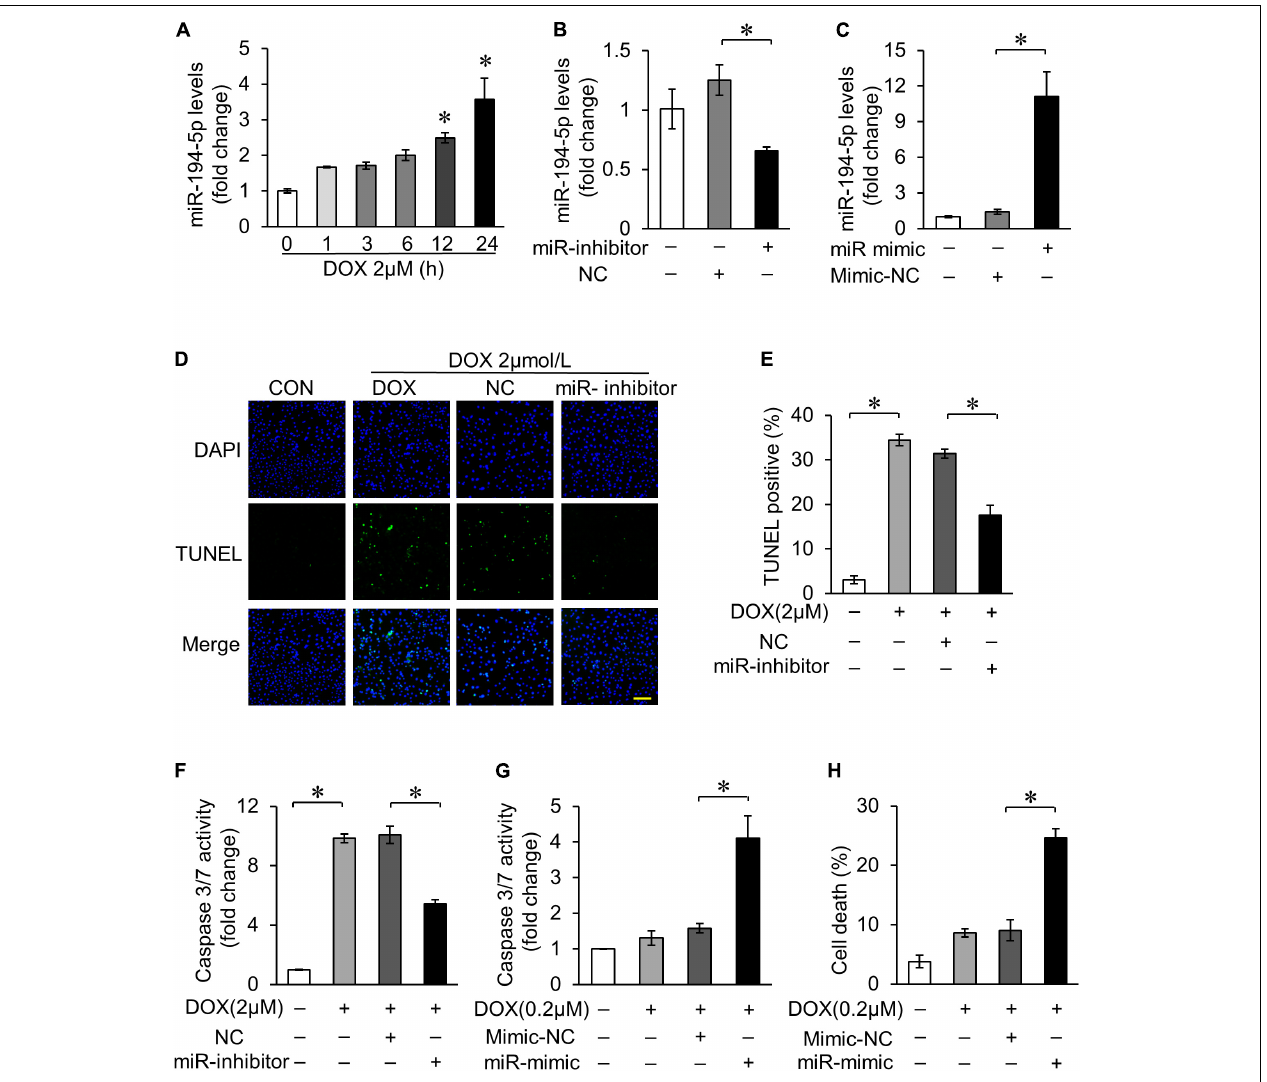
FIGURE 1 | MiR-194-5p participated in doxorubicin (DOX)-induced cardiomyocyte apoptosis. (A) H9c2 cells were treated with 2 µ M DOX for the indicated times. The expression levels of miR-194-5p were measured by qRT-PCR. ∗ p < 0.01 vs. control. (B) MiR-194-5p expression after transfection with miR-194-5p inhibitor for 24 h was measured by real-time quantitative PCR (qRT-PCR). (C) MiR-194-5p expression after transfection with miR-194-5p mimic for 24 h was measured by qRT-PCR. (D–F) Suppressed miR-194-5p expression with miR-194-5p inhibitor for 24 h and exposed cells to 2 µ M DOX for 24 h. Apoptosis was detected by terminal deoxinucleotidyl transferase dUTP nick-end labeling (TUNEL) assay (D) . Green, TUNEL-positive nuclei; blue, 4,6-diamidino-2-phenylindole (DAPI)-stained nuclei; scale bar, 200 µ m. Statistical analysis of TUNEL-positive cells (E) and caspase 3/7 activity (F) are shown. (G,H) Enhanced miR-194-5p expression